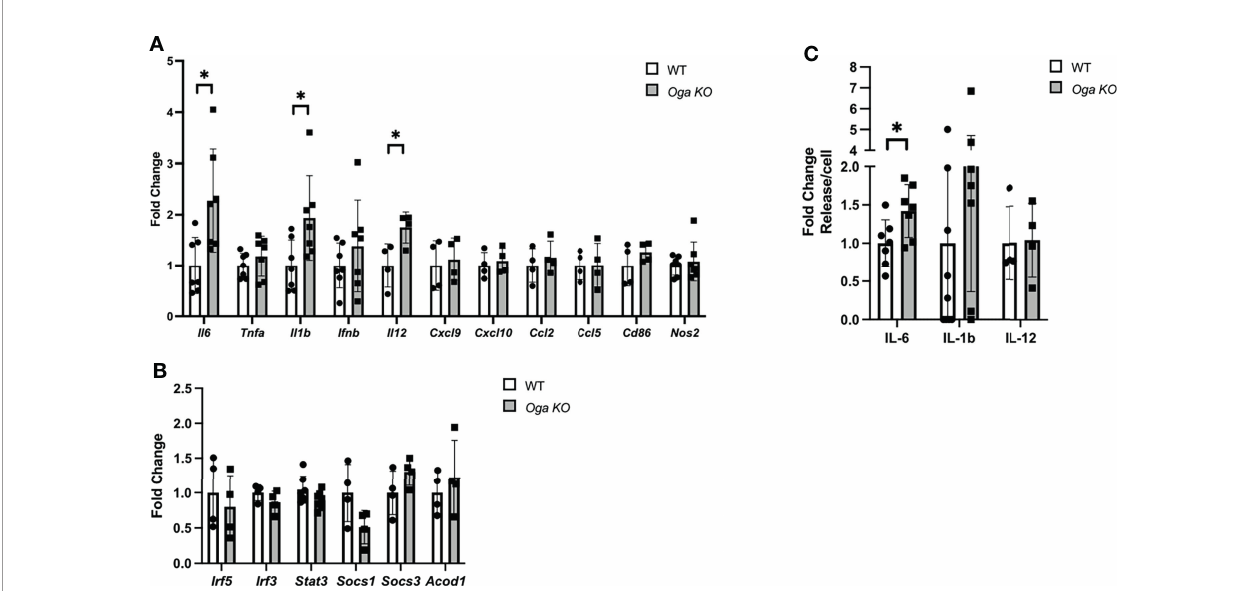
FIGURE 2 | Increase in speci fi c pro-in fl ammatory cytokine gene expression in M1 polarized OGA de fi cient BMDMs. (A, B) Gene expression of M1 markers (A) and transcription and metabolic regulators (B) in stimulated WT (white bars) and Oga KO BMDMs (grey bars), with respective genes indicated on the X-axis. Expression was normalized to the geometric mean of Rplp0 and Eef2 and represented as fold change. (C) ELISAs for IL-6, IL-1 b and IL-12 were performed using media from M1 polarized WT and Oga KO BMDMs. Levels of respective ILs were normalized to cell counts and represented as fold change. N = 4-7. Error bars represent standard deviations. *p < 0.05 as determined by student ’ s